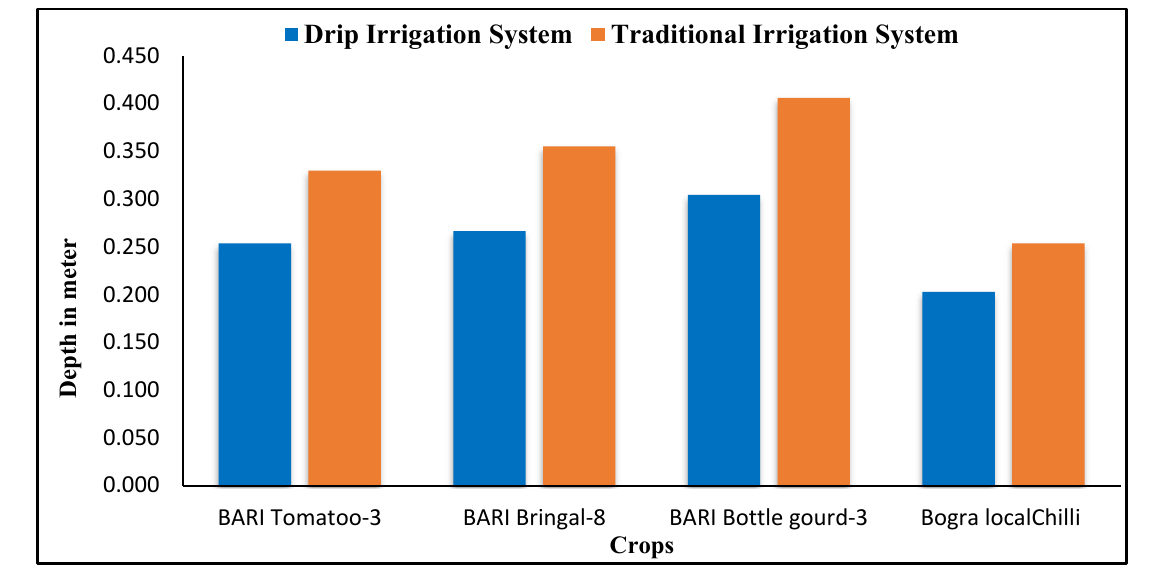
Figure 8. Maximum rootzone depth of selected crops in URTA with drip irrigation and traditional irrigation.